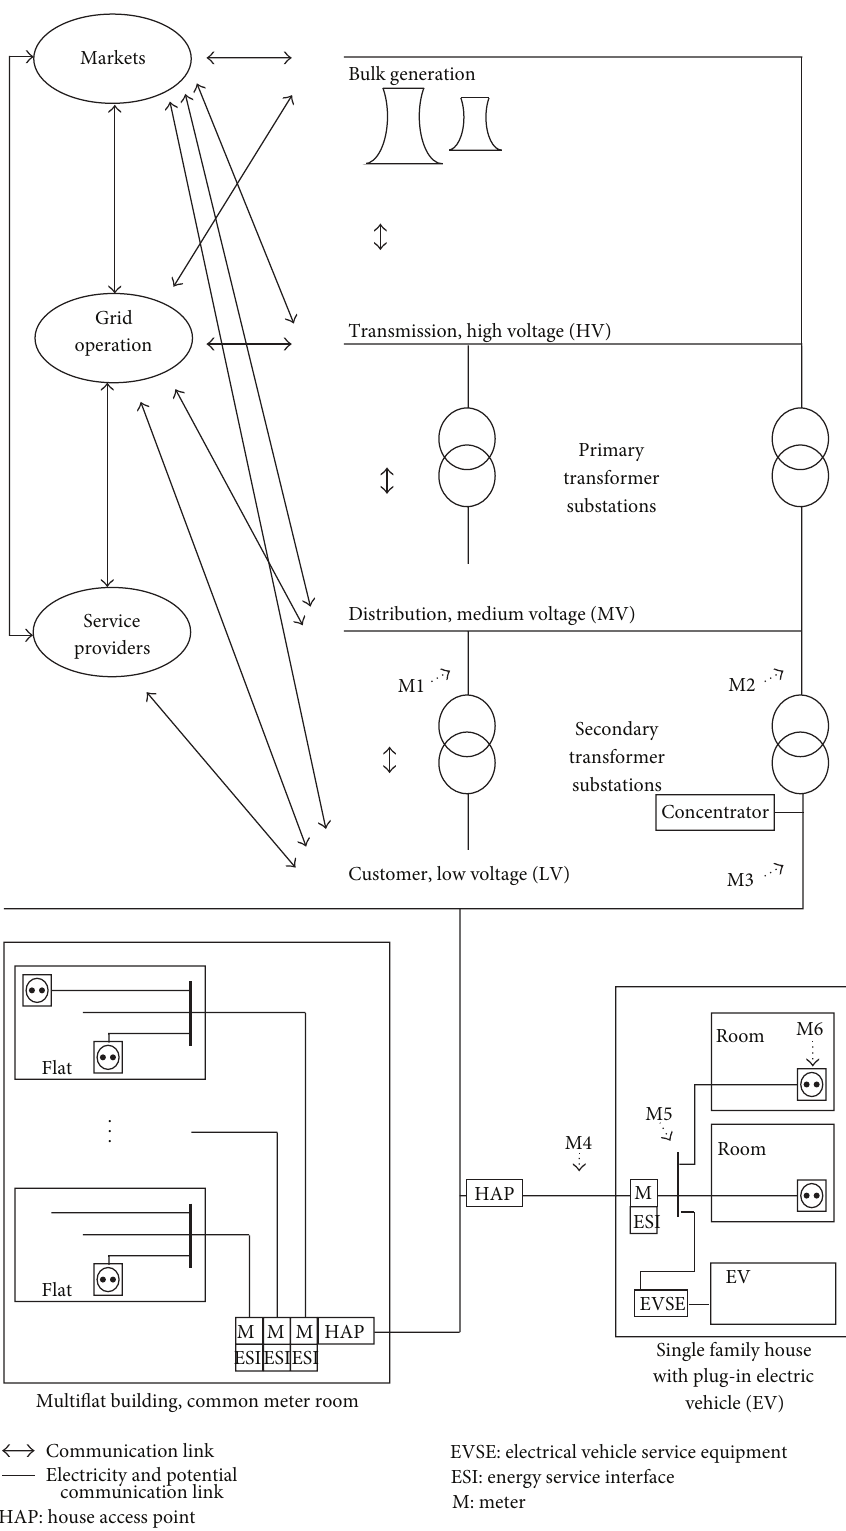
Figure 1: Smart Grid domains and their electrical and communication interconnections, based on Figure 7.1 in